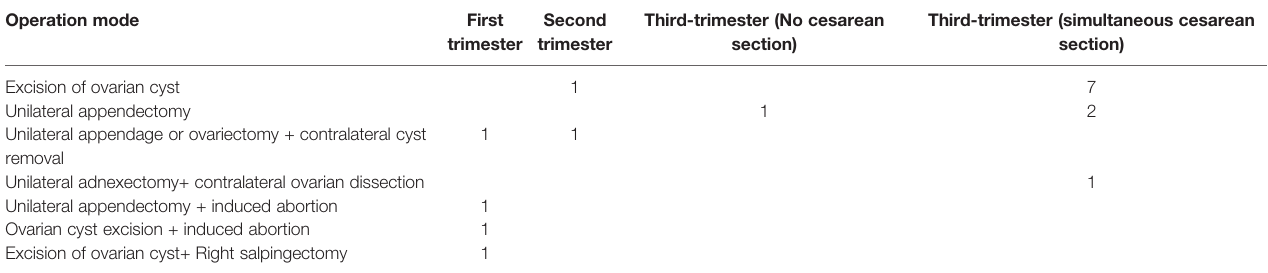
TABLE 2 | Operation method and operation